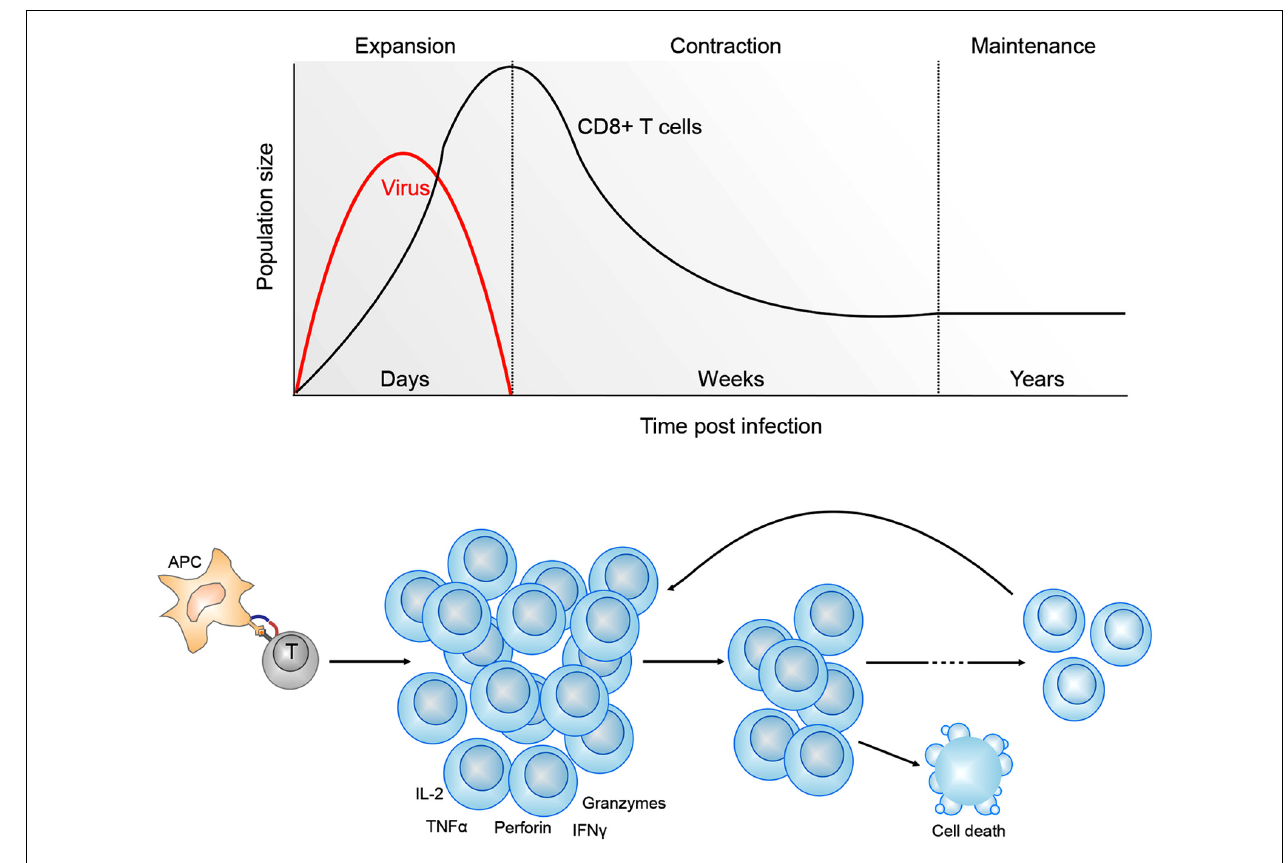
FIGURE 1 | Kinetics of CD8 + T cell differentiation following viral infection. Shown is a typical CD8 + T cell response to a acute viral infection. Antigen presenting cells (APC) present viral antigens to CD8 + T cells. This initiates a program of clonal expansion and differentiation into effector CD8 + T cells capable of lineage-specific effector functions, including the ability to secrete pro-inflammatory (TNF- α , IFN- γ ) and